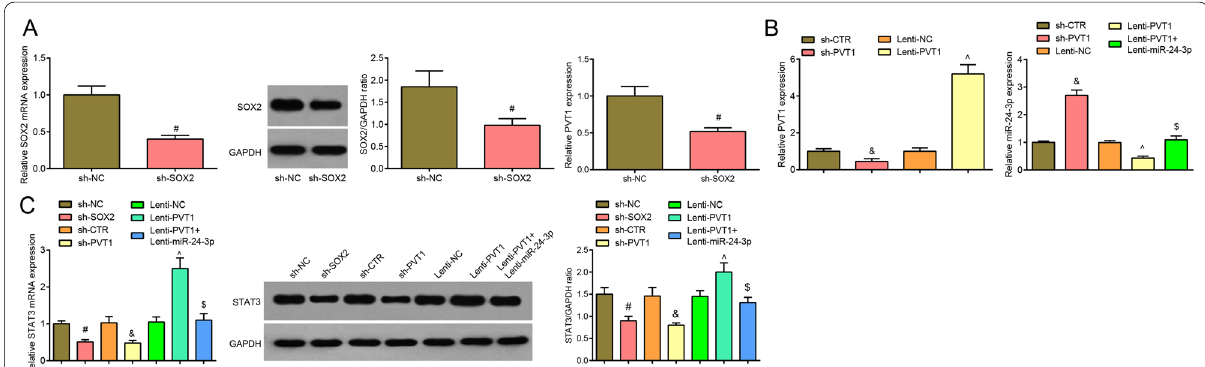
Fig. 2 Inhibited SOX2 or PVT1 upregulates miR-24-3p expression and downregulates STAT3 expression in MCAO rats. A SOX2, PVT1 expression in MCAO rats cerebral cortex tissues in each group after inhibition of SOX2; B PVT1, miR-24-3p expression in MCAO rats cerebral cortex tissues in each group after inhibition of PVT1; C STAT3 expression in MCAO rats cerebral cortex tissues in each group after inhibition of SOX2 or PVT1; n per group; # P < 0.05 compared with the sh-NC group; & P < 0.05 compared with the sh-CTR; ^ P < 0.05 compared with the Lenti-NC group; $ P < 0.05 compared with the Lenti-PVT1 group